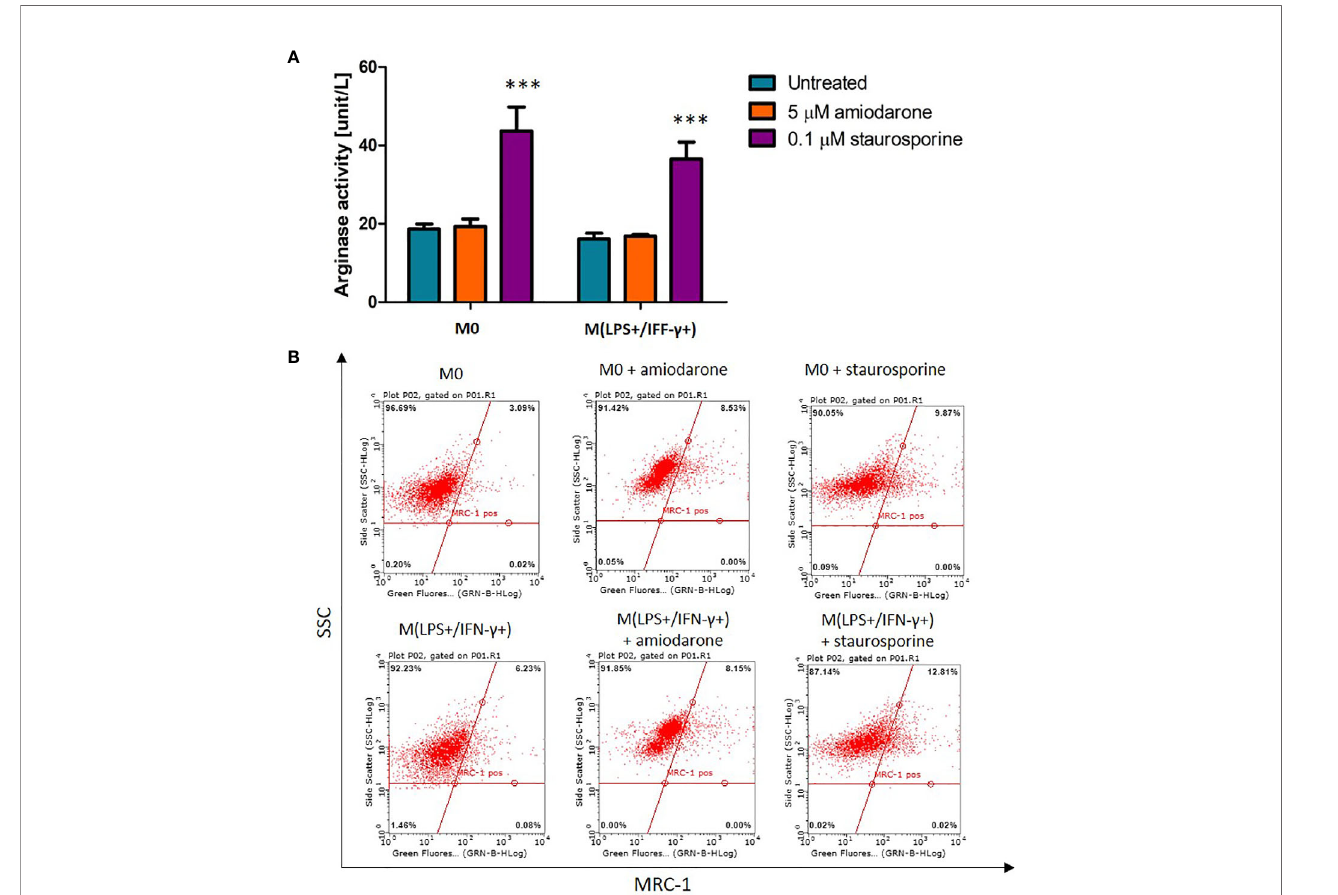
FIGURE 5 | Effect on arginase activity and MRC-1 receptor expression in M0-non-activated and IL-4 activated NR8383 rat macrophages after 24 h exposure to 5 µM amiodarone and 0.1 µM staurosporine. (A) Effect on arginase activity. Data are normalized to cell count and presented as mean values ± SEM of three separate experiments. Statistical comparisons are made using a one-way ANOVA analysis with Bonferroni ’ s multiple comparison post-hoc test. Results are compared to non- polarized control (M0); *** indicates p < 0.001. (B) Representative fl uorescent dot (quadrants) plots showing percentage of cells expressing MRC-1 surface